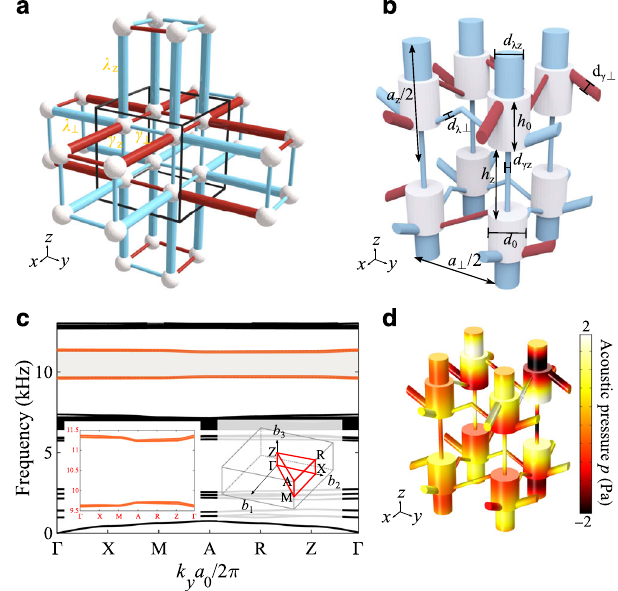
Fig. 1 Acoustic octupole topological insulator. a Geometry for minimal tight-binding model of octupole topological insulator, γ ? and λ ? are the intra-cell and inter-cell couplings in the plane perpendicular to z axis, and γ z and λ z are the intra-cell and inter-cell couplings in the z direction. b Unit cell design of acoustic tetragonal crystal that guarantees the negative coupling at each plaquette of the lattice, geometry parameters are provided in the Methods. c Band structures of the acoustic unit cell in ( b ), shaded gray region indicates the frequency bandwidth of interested bands (orange colored), inset fi gures show fourfold degenerate band structures of interest (slight deviation due to meshing in numerical calculation) and high- symmetry lines and points in the tetragonal Brillouin zone, respectively. d Acoustic pressure pro fi le of the acoustic coupled dipolar modes taken at the high-symmetry point